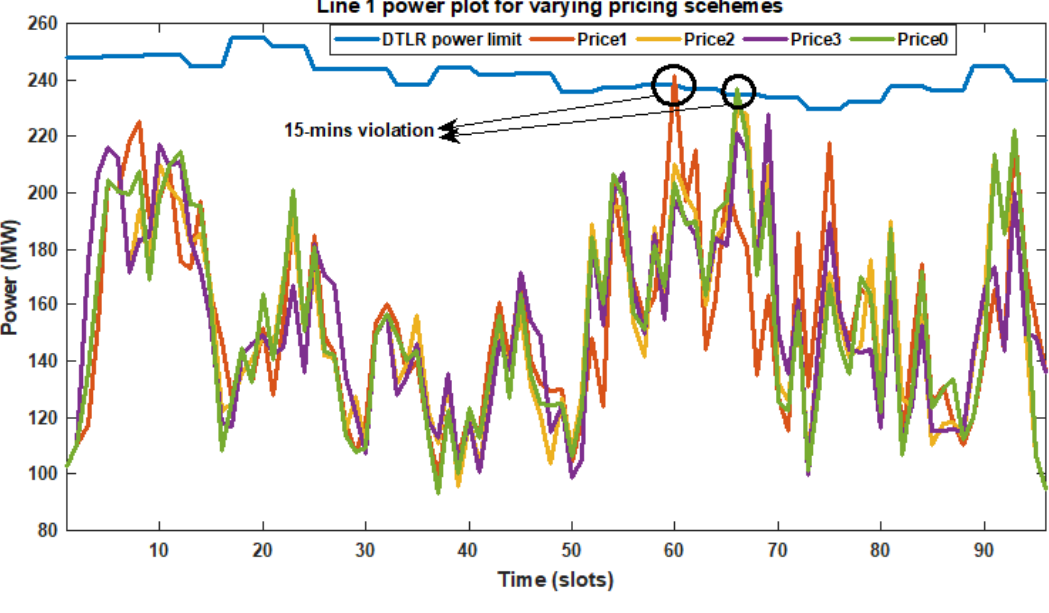
Figure 9. Line 1 power variation for all pricing